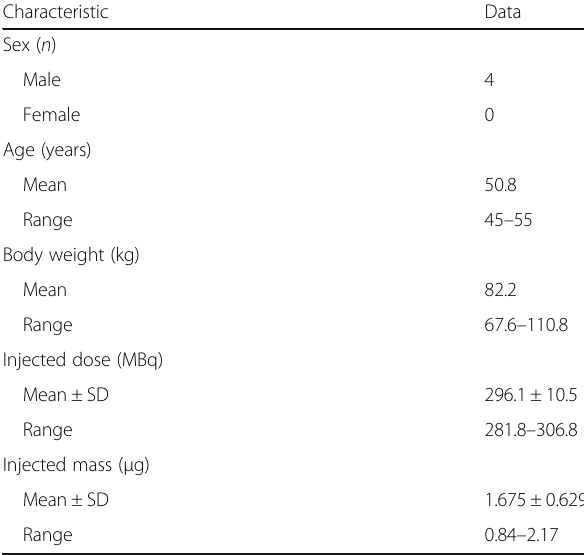
Table 1 Patient characteristics